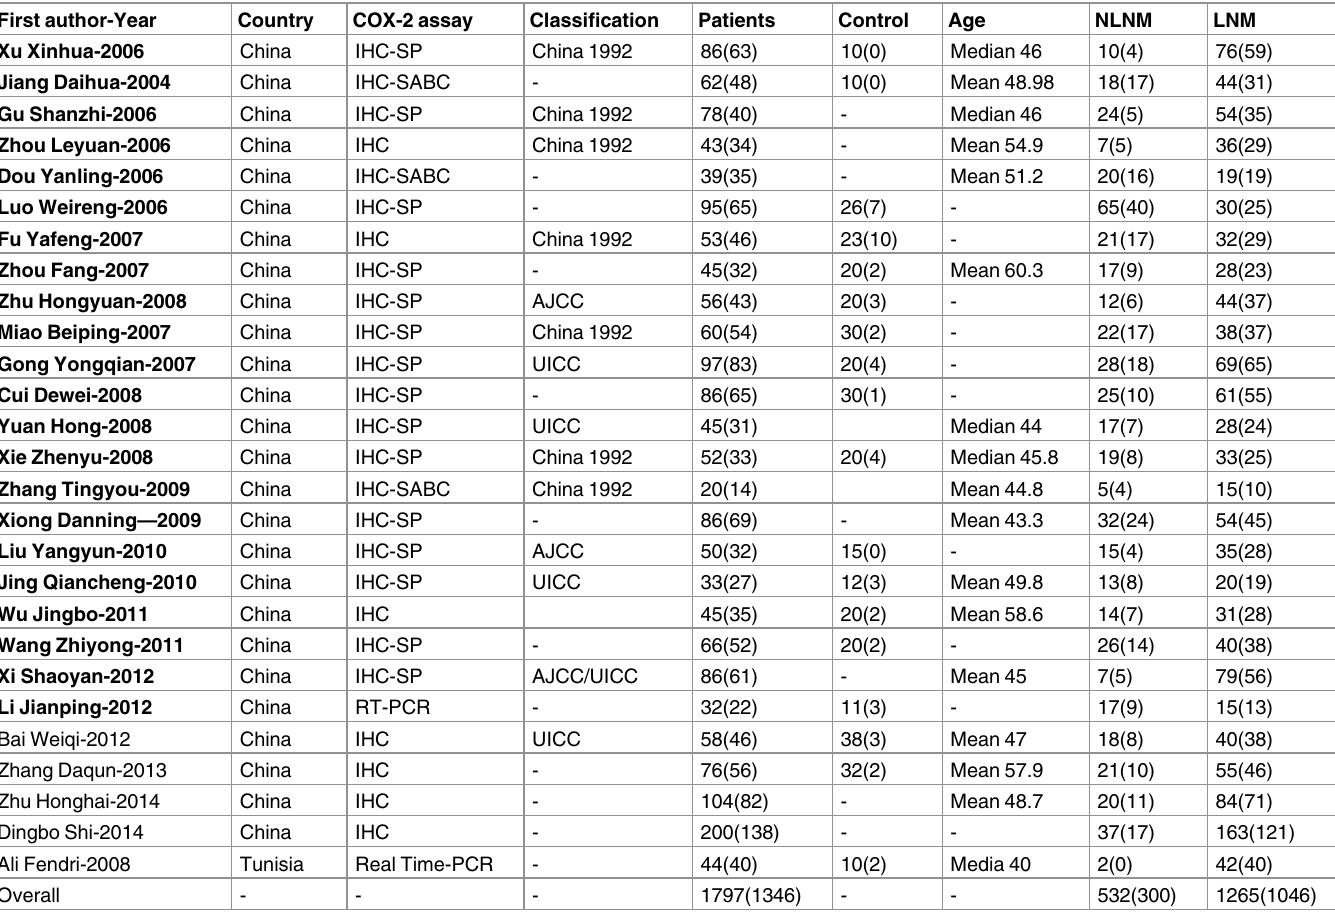
Table 1. Main characteristics of included